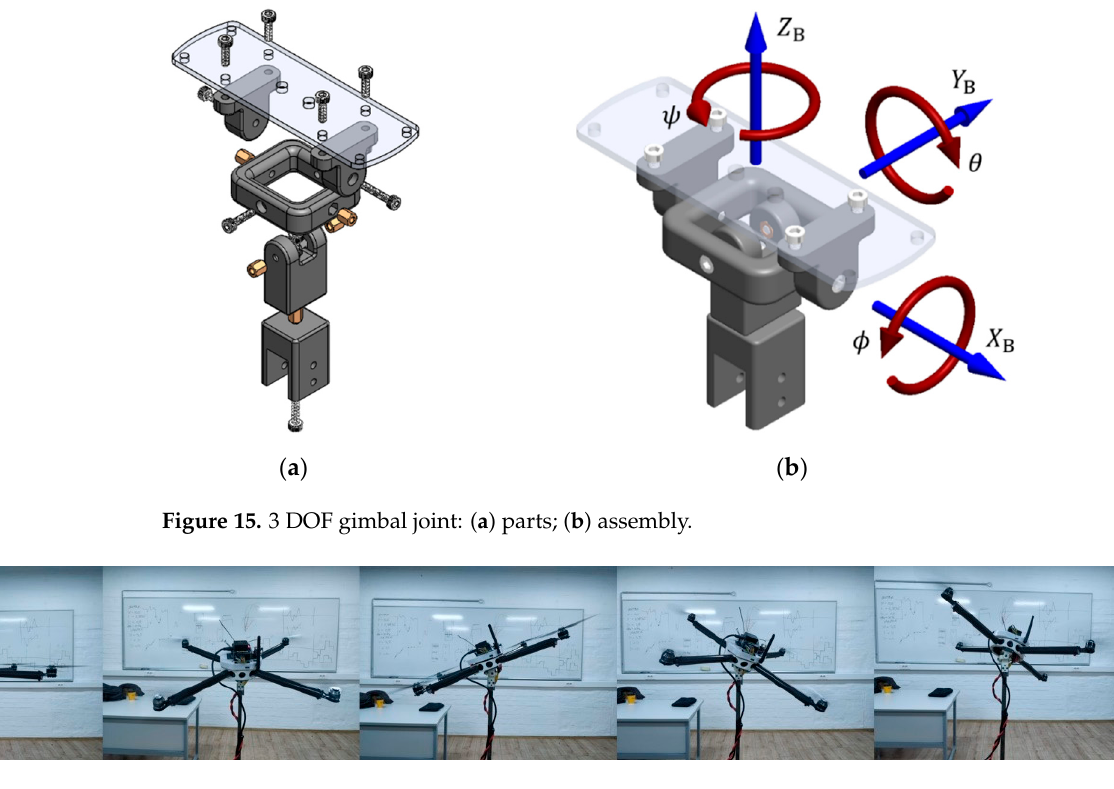
Figure 16. Experimental testing of attitude control on conventional flat quadrotor configuration (FX4).